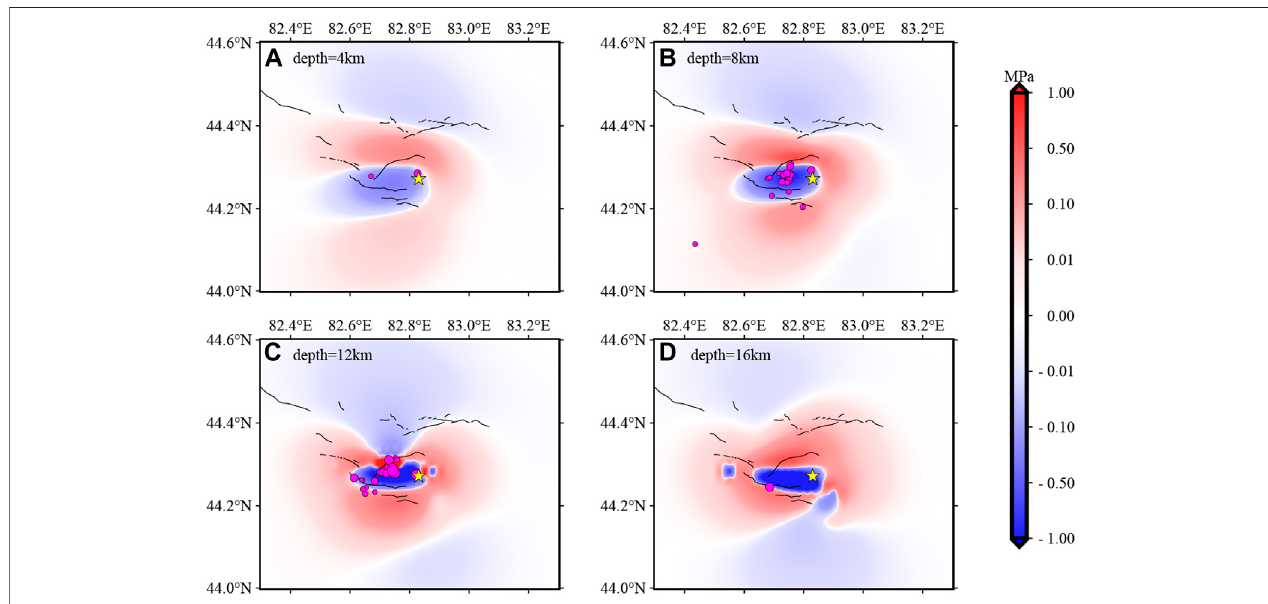
FIGURE 5 | Coseismic Coulomb stress changes of slip distribution are constrained by IPGP with the receiving fault of the mainshock. (i.e., strike (cid:2) 99 ° , dip (cid:2) 45 ° , rake (cid:2) 106 ° , and friction (cid:2) 0.8). Coulomb stress changes at depths of 4, 8, 12, and 16 km, respectively. The black lines denote the active faults. The 2 – 6 km deep aftershock projection was in the 4 km plane (A) , the 6 – 10 km deep aftershock projection in the 8 km plane (B) , the 10 – 14 km deep aftershock projection in the 12 km plane (C) , and the 14 – 18 km deep aftershock projection in the 16 km plane (D) . The aftershocks ( M ≥ 2.0) are denoted by black circles fi lled with rose. The epicenter of the mainshock is denoted by a yellow